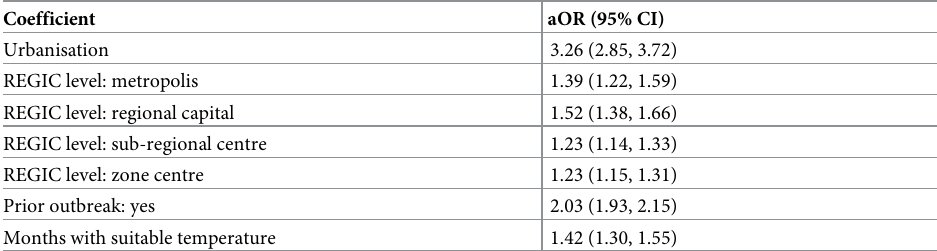
Posterior mean and credible interval estimated taking the 50th, 2.5th and 97.5th quantiles from the simulated posterior distribution. The response variable is a dengue outbreak, defined as over 300 cases per 100,000 residents. Urbanisation is the proportion of residents living in urban areas. REGIC covariates are in comparison to the reference group, local centre. A suitable temperature is defined as between 16.2˚C and 34.5˚C (suitable for both Aedes aegypti and Aedes albopictus